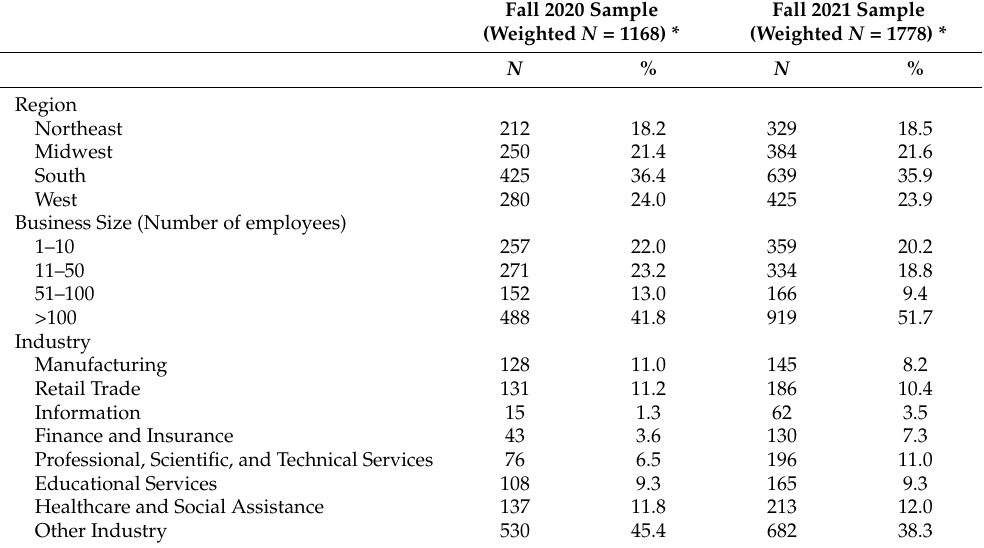
Table 1. Business Characteristics Reported by Survey Respondents in Fall 2020 and Fall 2021.